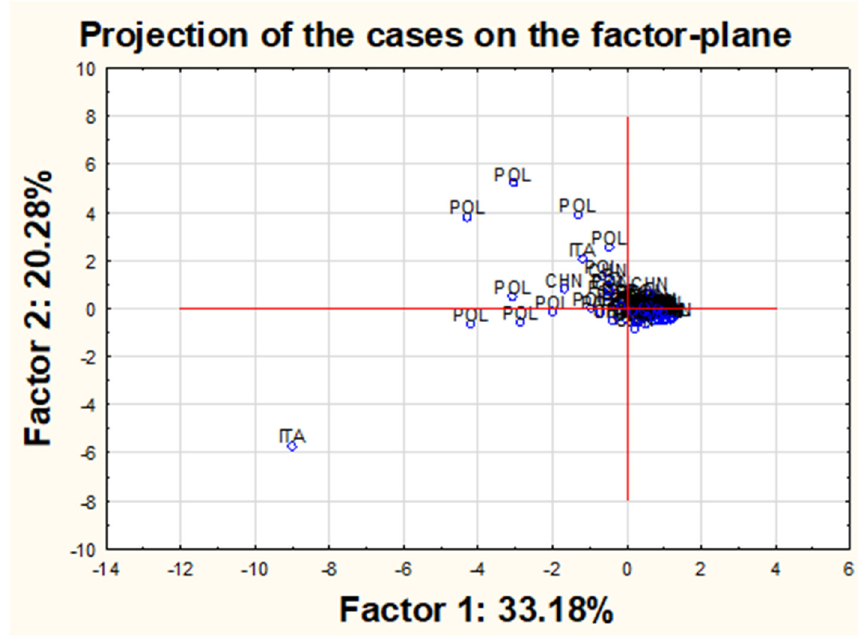
Figure 10. Projection of objects for the first two components for reduced data set (after the rejection of the following outliers: samples No. 32, 33, 39, 56, 57, 66, 68, 70, 71, 72, 91 and